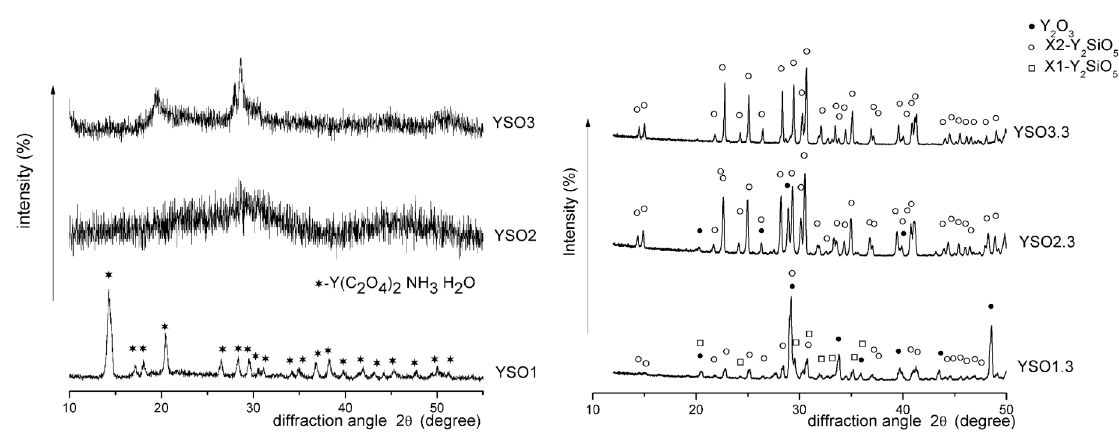
Figure 5. Normalised XRD diffractograms of precursors (left) and phosphors (right), λ